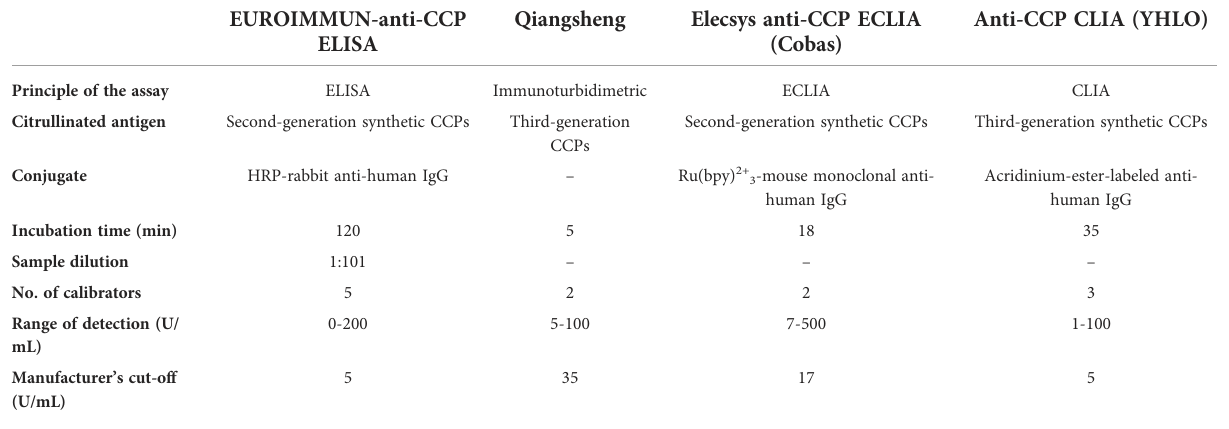
TABLE 1 Characteristics of anti-CCP